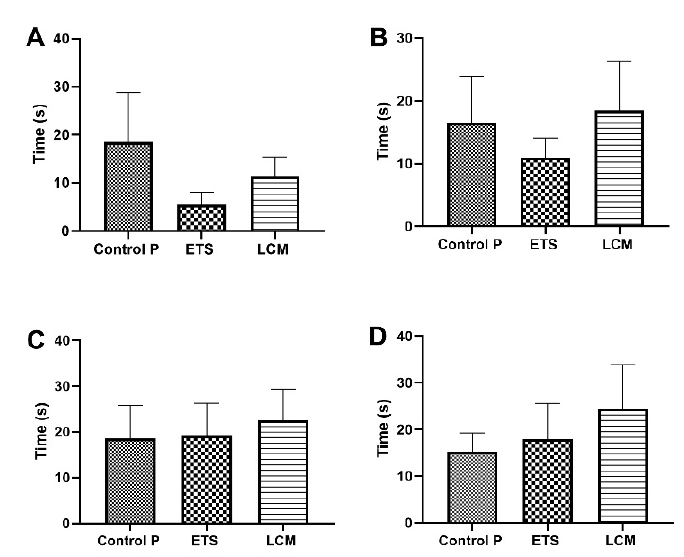
Figure 3. The impact of long-term treatment with ETS and LCM on escape latency after PILO induced SE in mice.( A ) Target quadrant IQ; ( B ) Left quadrant IIQ; ( C ) Opposite quadrant IIIQ; ( D ) Right quadrant IVQ.